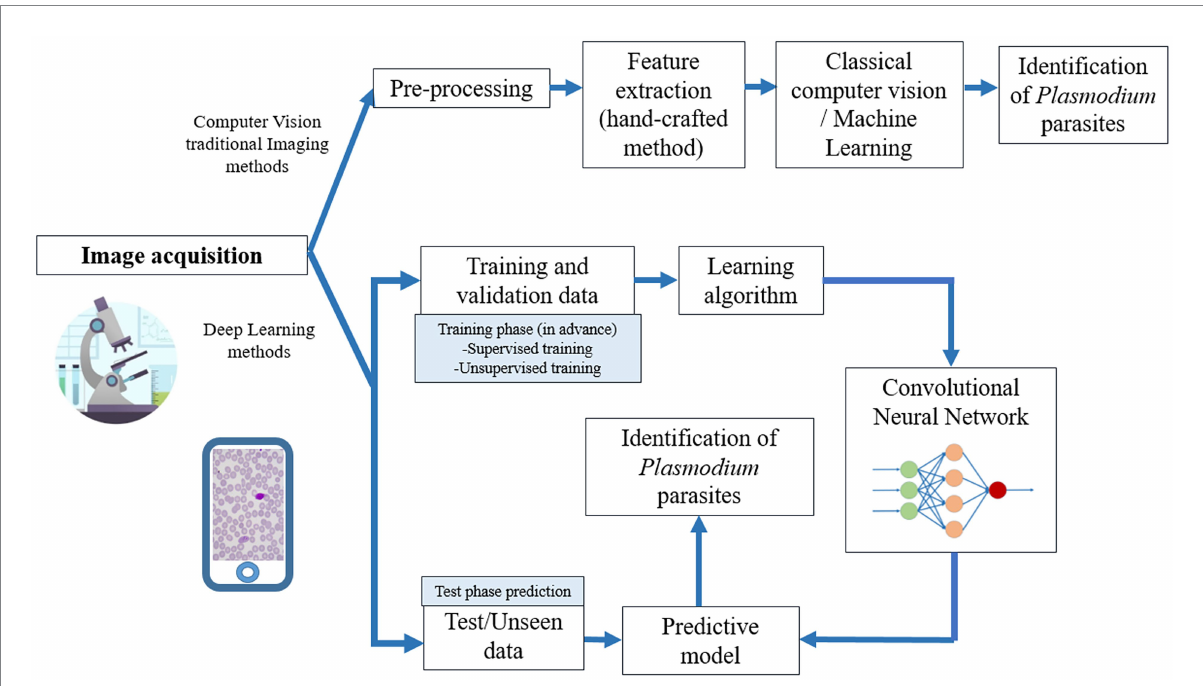
FIGURE 3 Representation of the different procedures using Traditional Computer Vision Imaging methods or Deep Learning methods (Convolutional Neural Networks) for malaria parasite identification in thick and thin blood smear